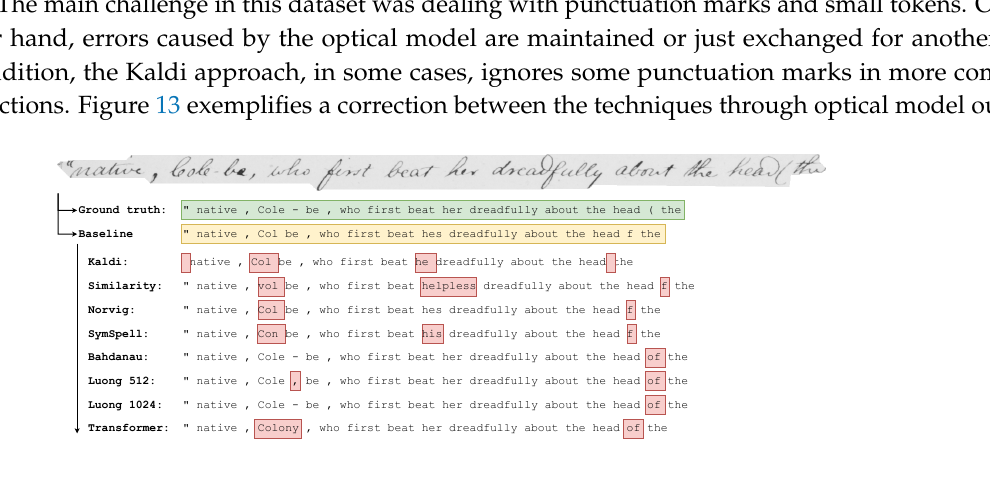
Figure 13. Correction sample in the Bentham